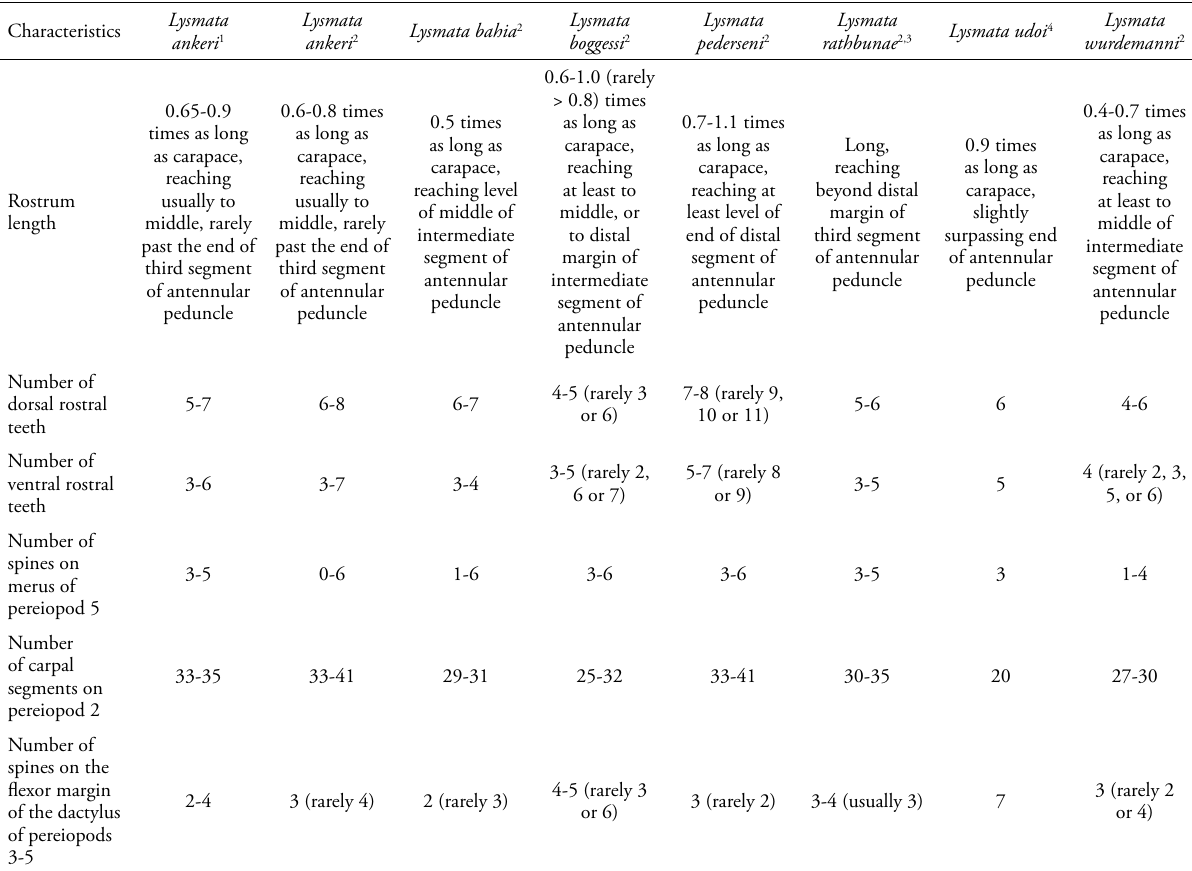
Table 1. Comparison of morphological characteristics of Lysmata ankeri captured on the subtidal rocky bottom at Couves Island, northern coast of São Paulo State with other species on the on the Lysmata wurdemanni complex. Characteristics